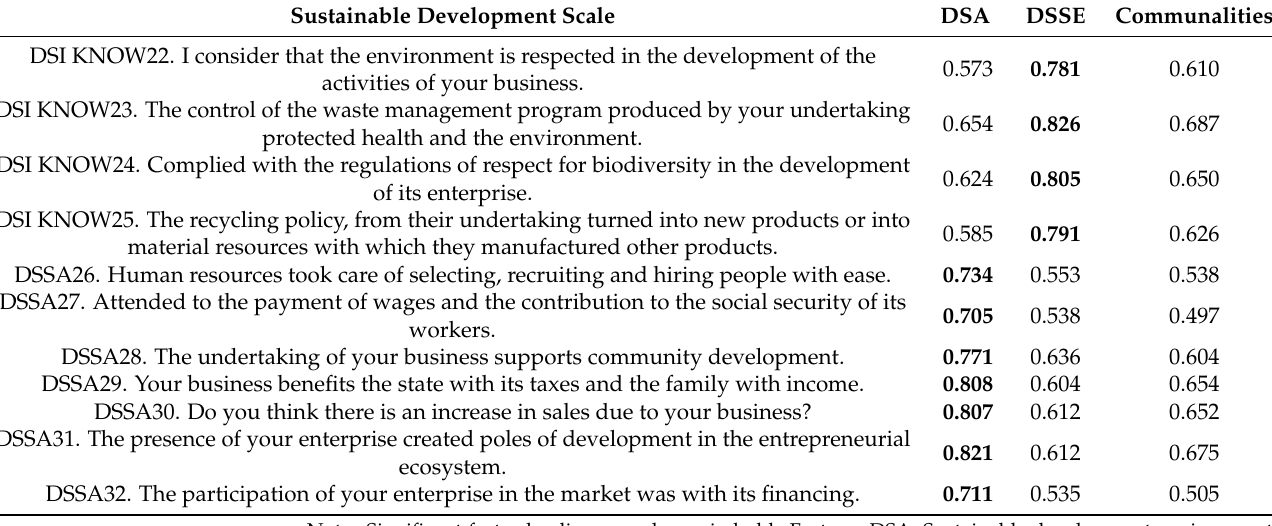
Table 4. Exploratory factorial analysis for Sustainable Development Perception ( n =